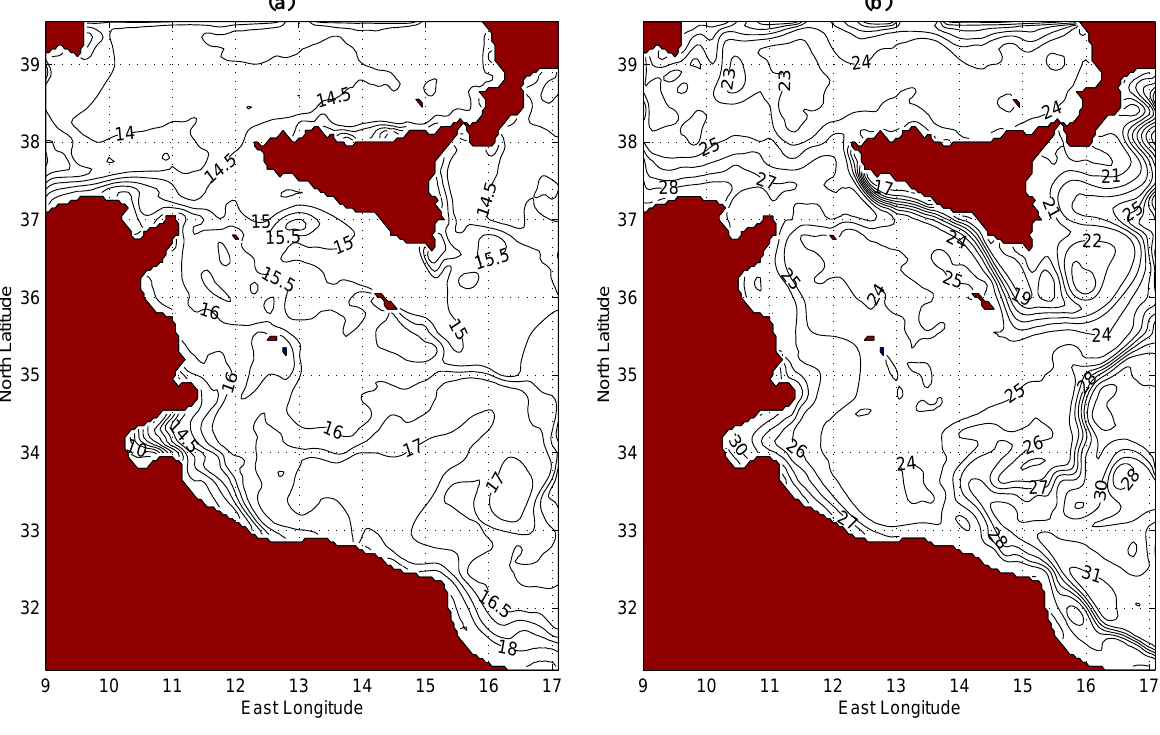
Fig. 11. The simulated 10-day averaged temperature field at 5m depth in (a) February and (b) August. The contour interval is 0.5 ◦ C in February and 1 ◦ C in August.